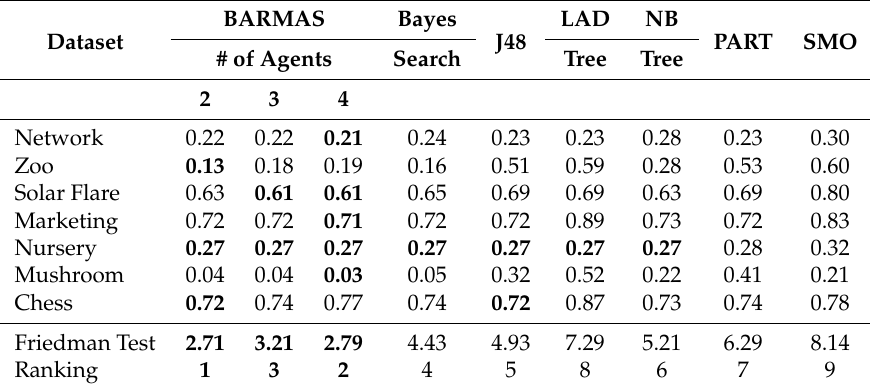
Table 5. Contrarily, comparable values are observed (with equal uncertainty levels) in other datasets, such as Solar Flare, Marketing, Nursery, Chess or Network. Table 5. Results with 50% missing attributes. Best results are marked in bold.